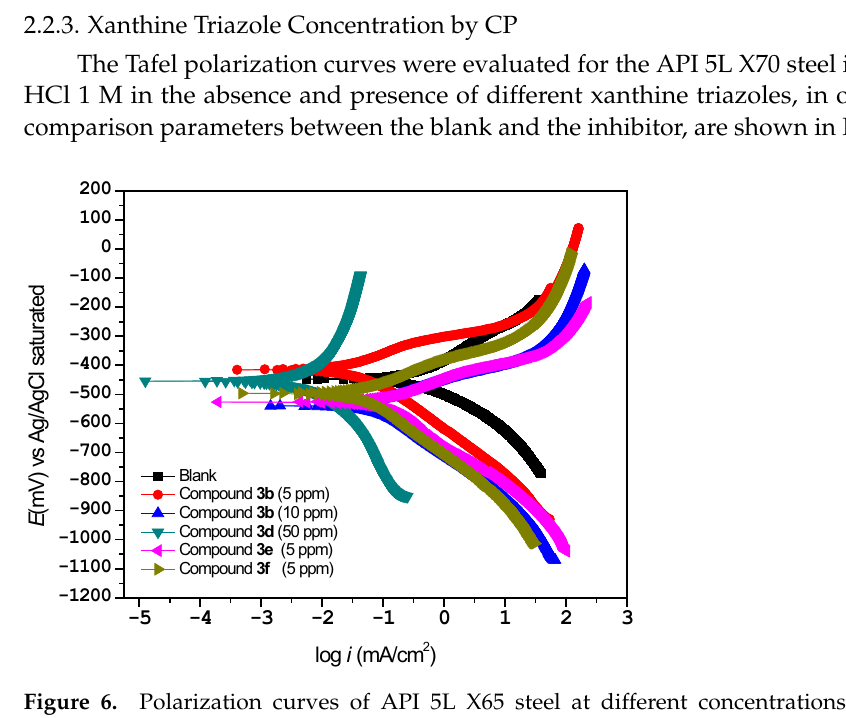
Figure 6. Polarization curves of API 5L X65 steel at different concentrations of inhibitor in saline medium.